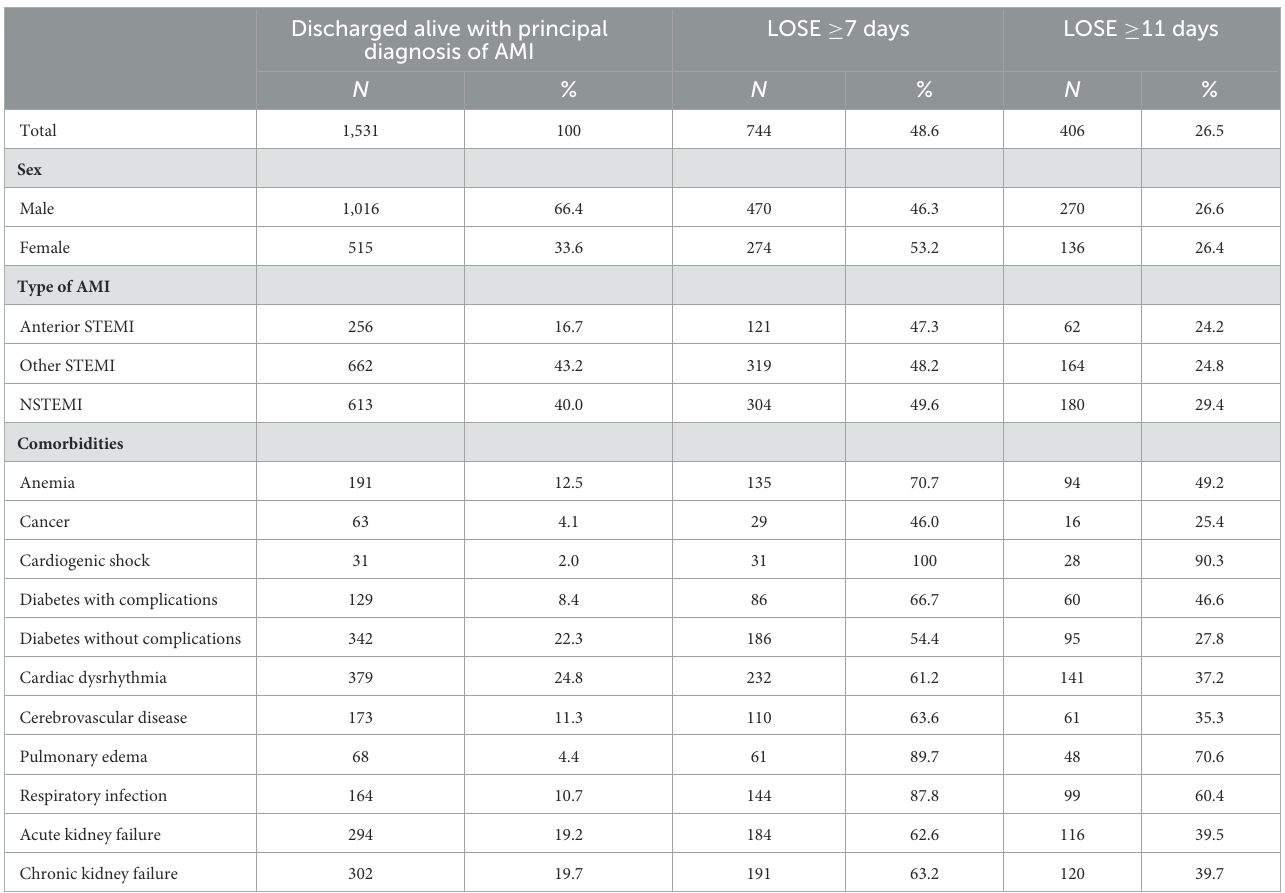
TABLE 1 Descriptive statistics of the study population—Administrative